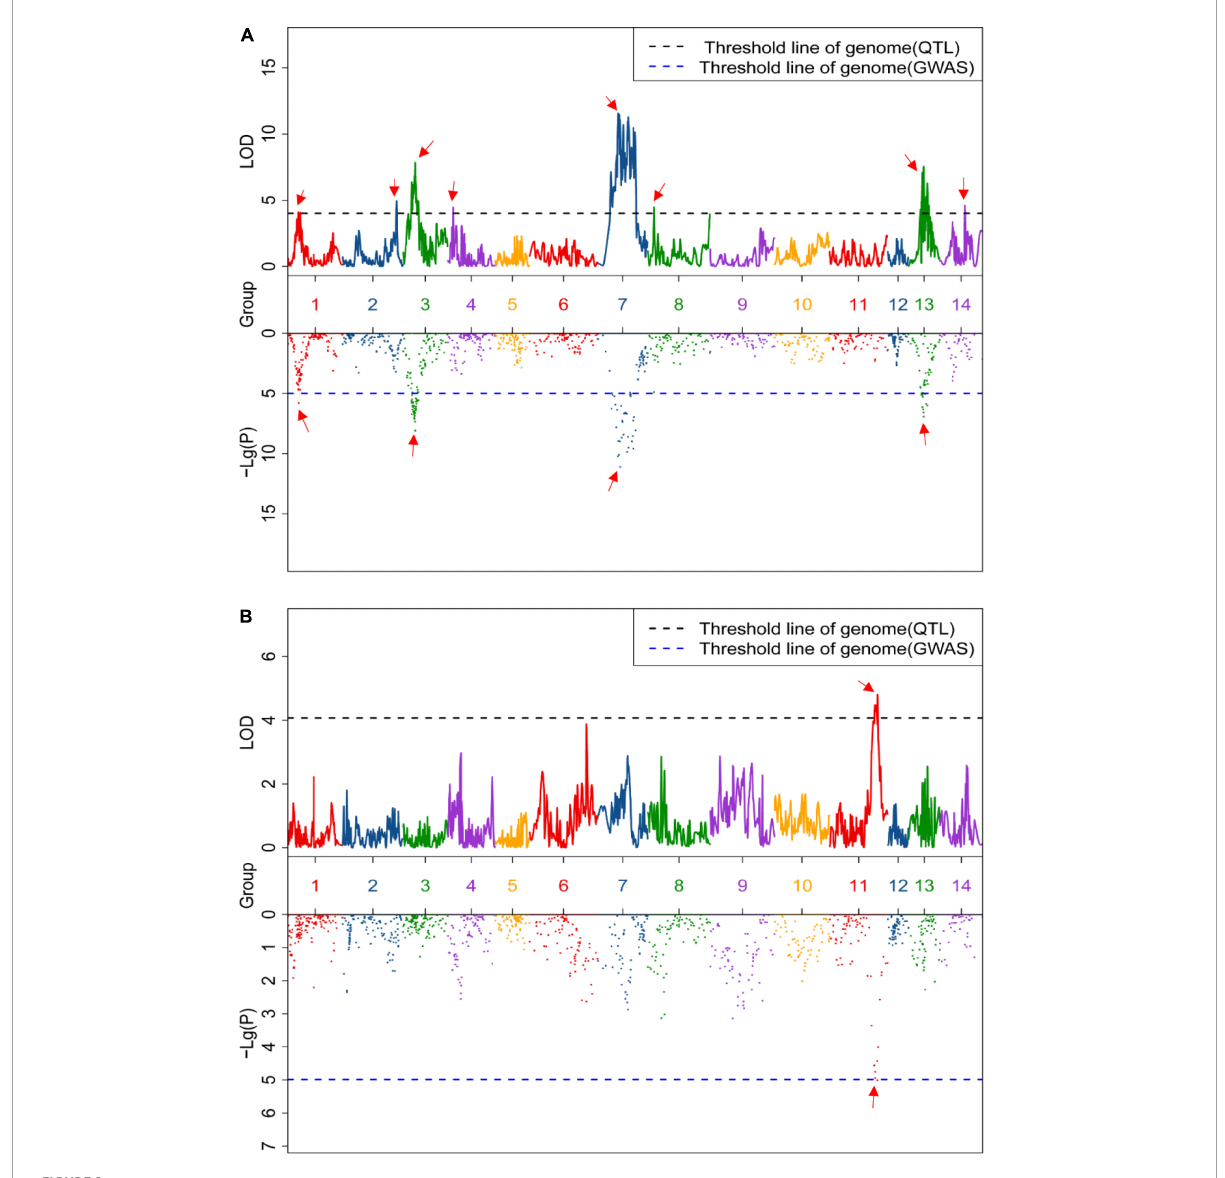
FIGURE2 Quantitative trait loci (QTLs) of the content of crude fiber (A) and crude protein (B) . Upper and lower box indicates the genome-wide LOD value from linkage mapping and the Manhattan plot from association analysis, respectively. Black and blue dashed lines represent the significance threshold value, and the red arrow indicates the significant peak of the QTLs.